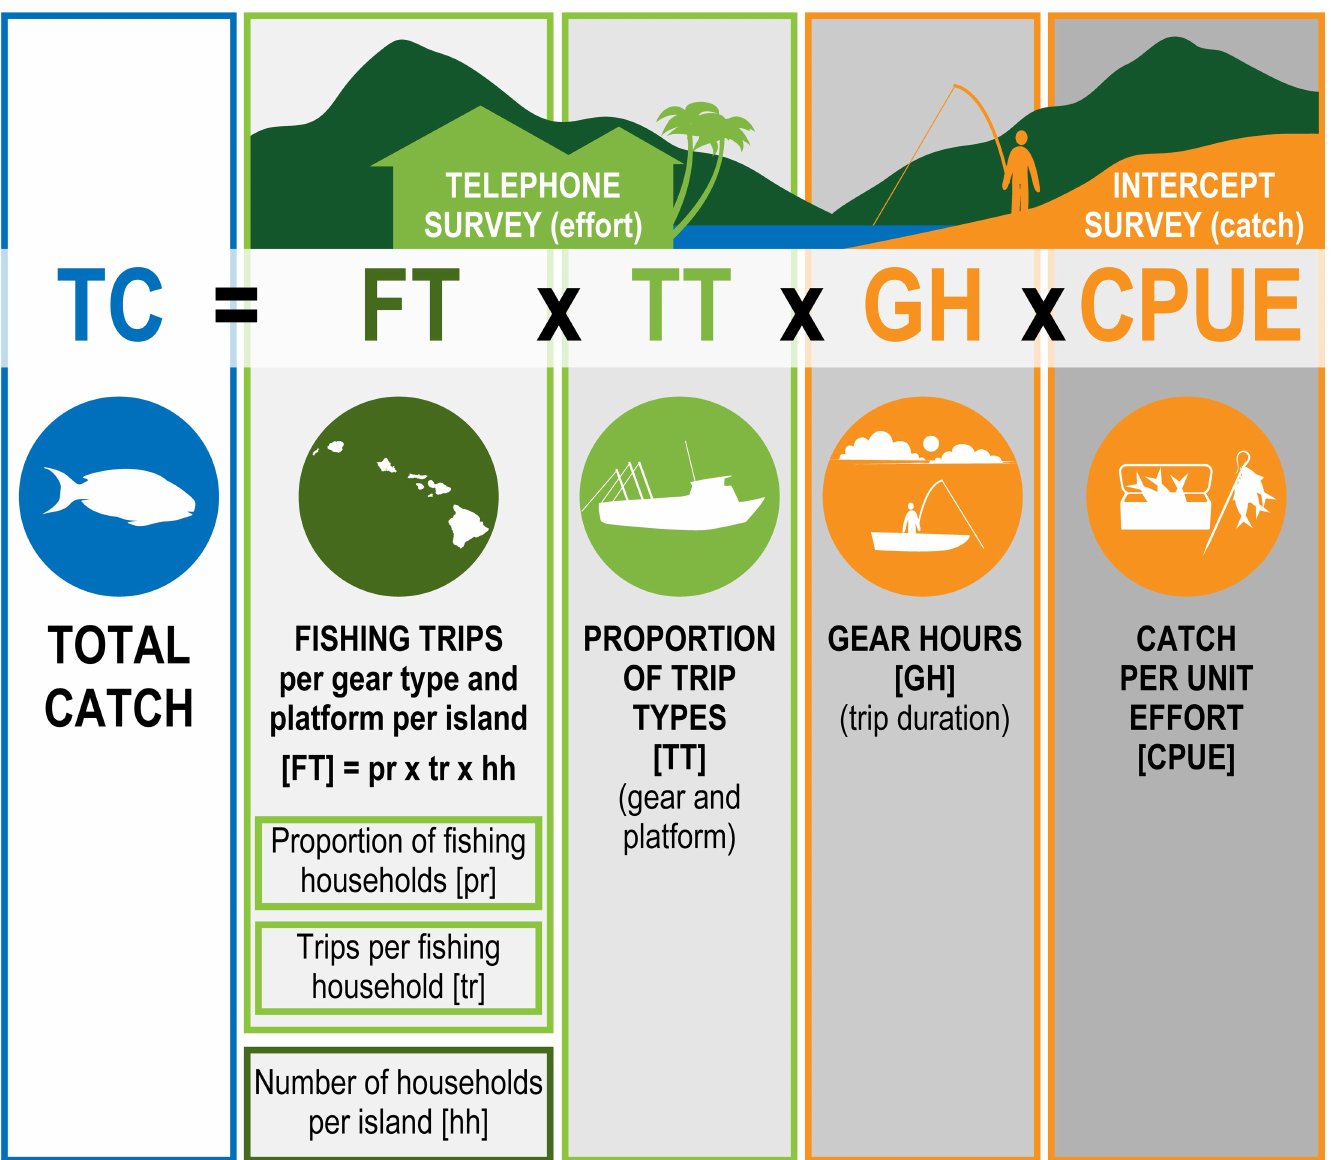
Fig 1. Total catch calculations from MRIP surveys. Information came from telephone effort surveys (outlined in green) or intercept surveys (outlined in orange), and correspond with the variables in Eq 5.